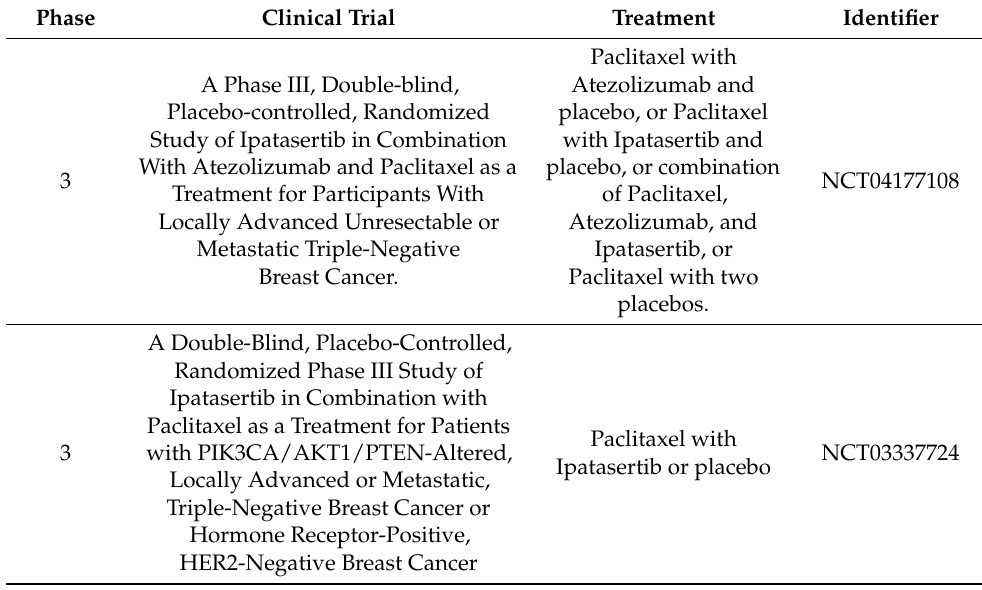
Table 4. List of active non-recruiting trials of PI3K/AKT/mTOR in